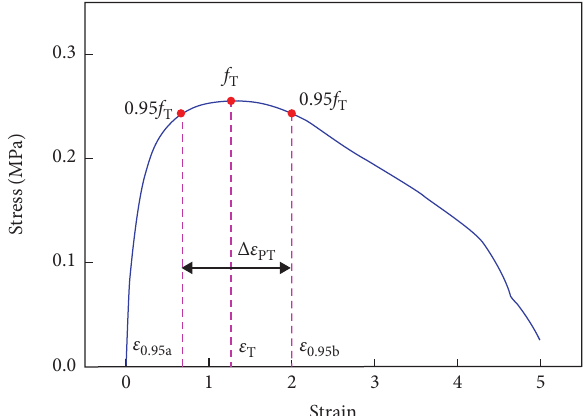
Figure 9: Definition and calculation of plateau tensile strain.